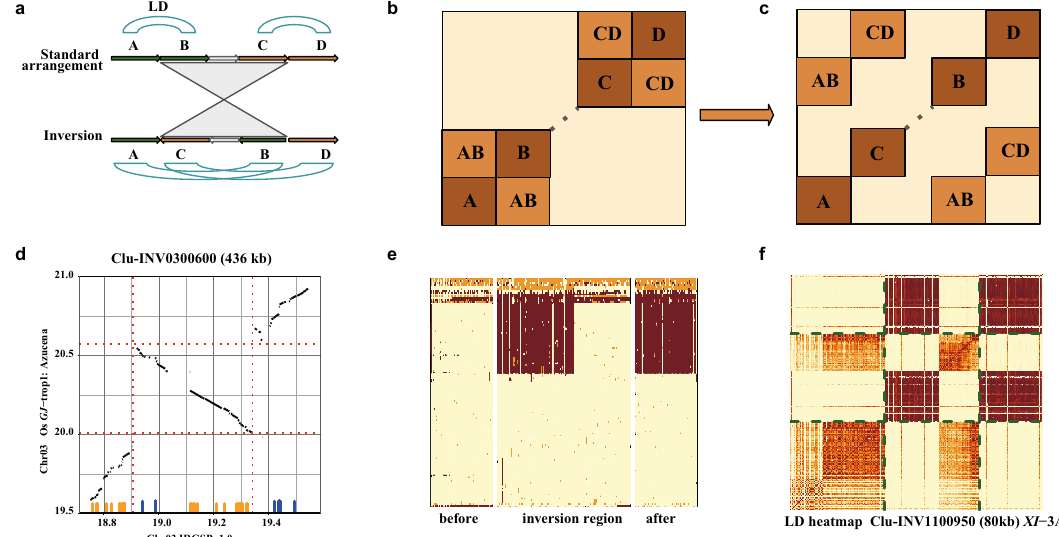
Fig. 7 | Population linkage disequilibrium analysis of large inversions. A sche- matic diagram of linkage disequilibrium (LD) block disruption arising from the presence of an inversion, as shown in A and B. a Cartoon view of an inversion with breakpointsdisruptingtwoLDblocks; b ExpectedfeaturesofthecorrespondingLD heat map; c Example of SNP blocks in high LD that are disrupted by an inversion; d The panel shows alignments, with the inversion marked by dotted lines. Small vertical lines above the horizontal axis mark the location of SNPs constituting a disrupted LD block. Orange and blue colors delineate two LD blocks that are contiguous in the of GJ -trop1 population, but appear as split when aligned to the